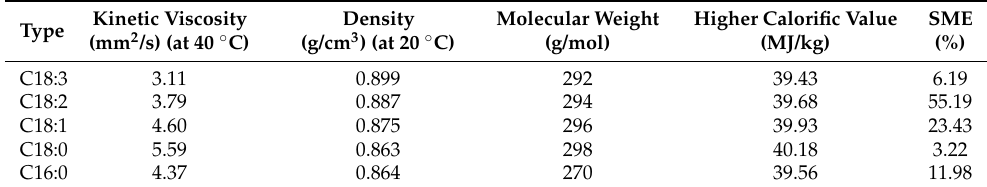
Table 2. Physical properties of FAMEs in soybean